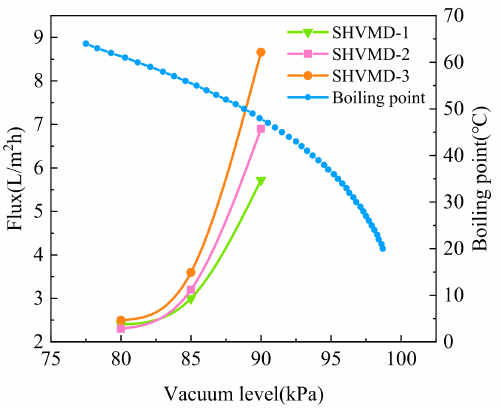
Figure 3. Changes in flux and boiling point of solution with the vacuum level.